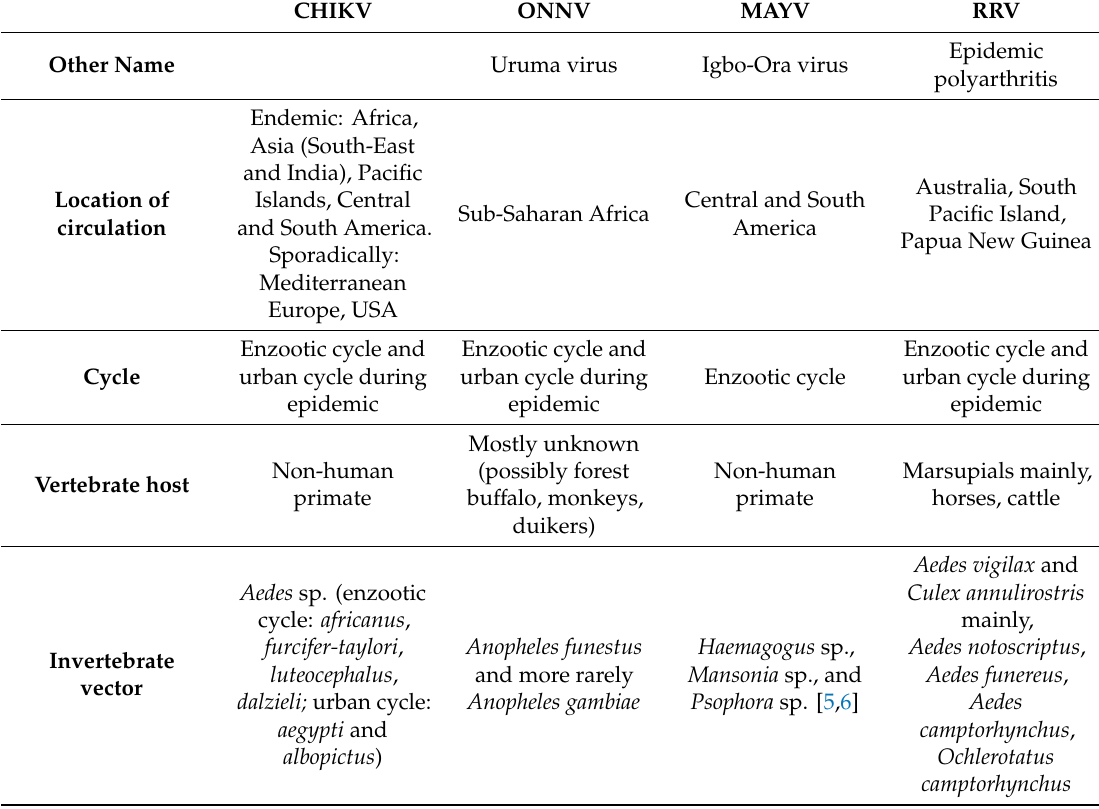
Table 1. Arthritogenic alphavirus general characteristics. CHIKV, chikungunya virus;